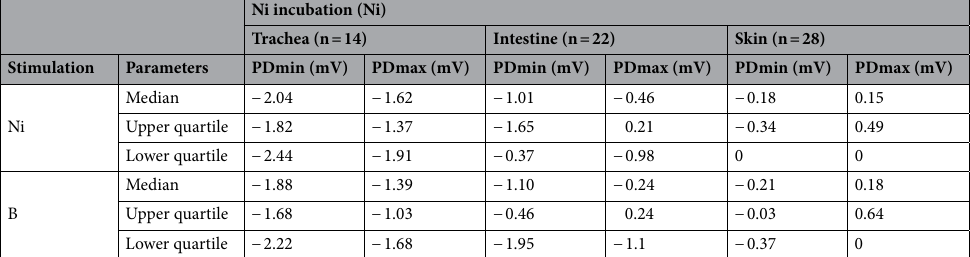
Table 8. Minimal (PDmin) and maximal (PDmax) transepithelial electric potential measured during 15-s mechanical-chemical stimulations by nickel chloride (0.1 mM) and bumetanide (B, 0.1 mM). The values of medians and lower and upper quartiles are given. Abbreviations: B—bumetanide (0.1 mM) solution, Ni— nickel chloride (0.1 mM) and bumetanide (0.1 mM) solution, p < 0.05;